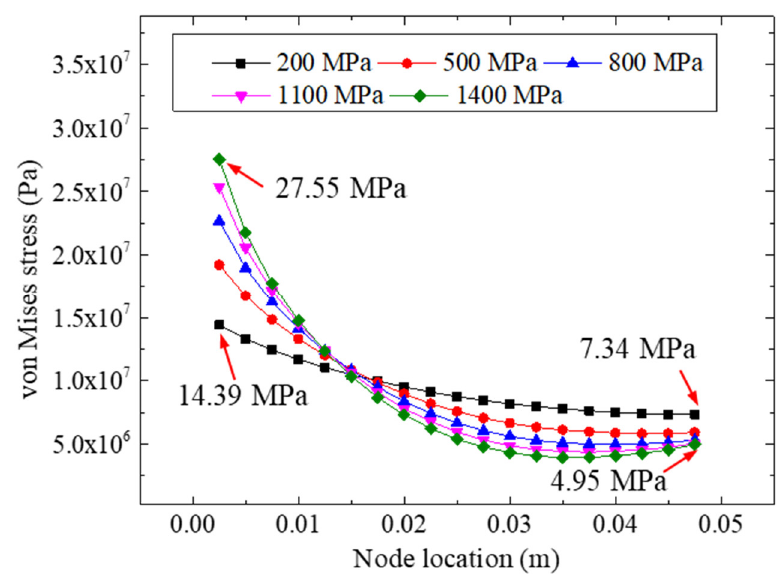
Figure 18. The von Mises stresses for different adhesive modulus.